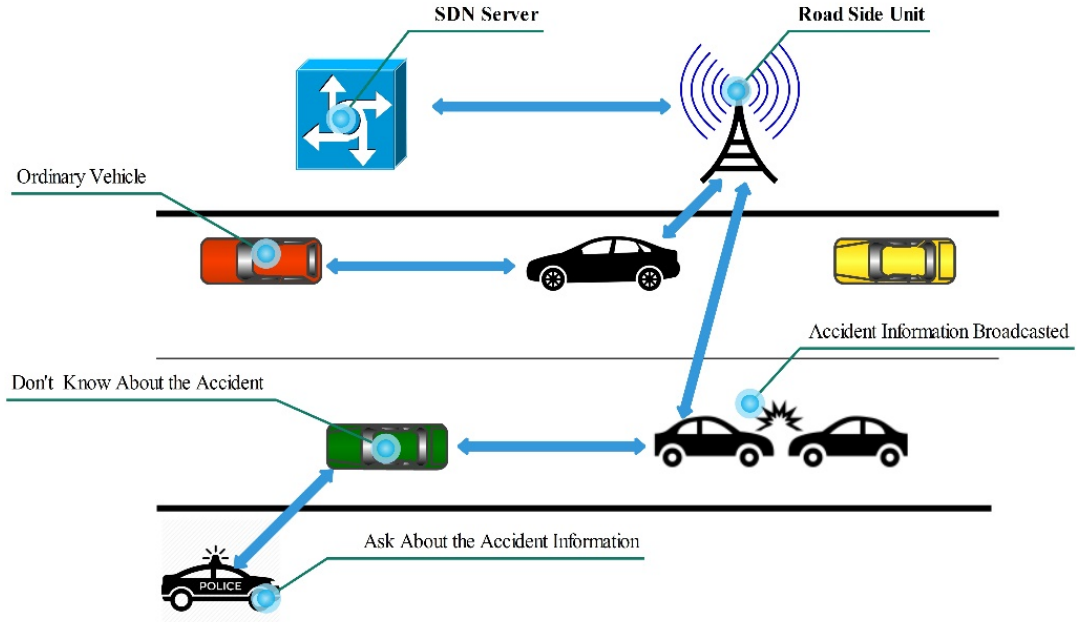
Figure 15. Impersonation attack in SDN-based VANETs.